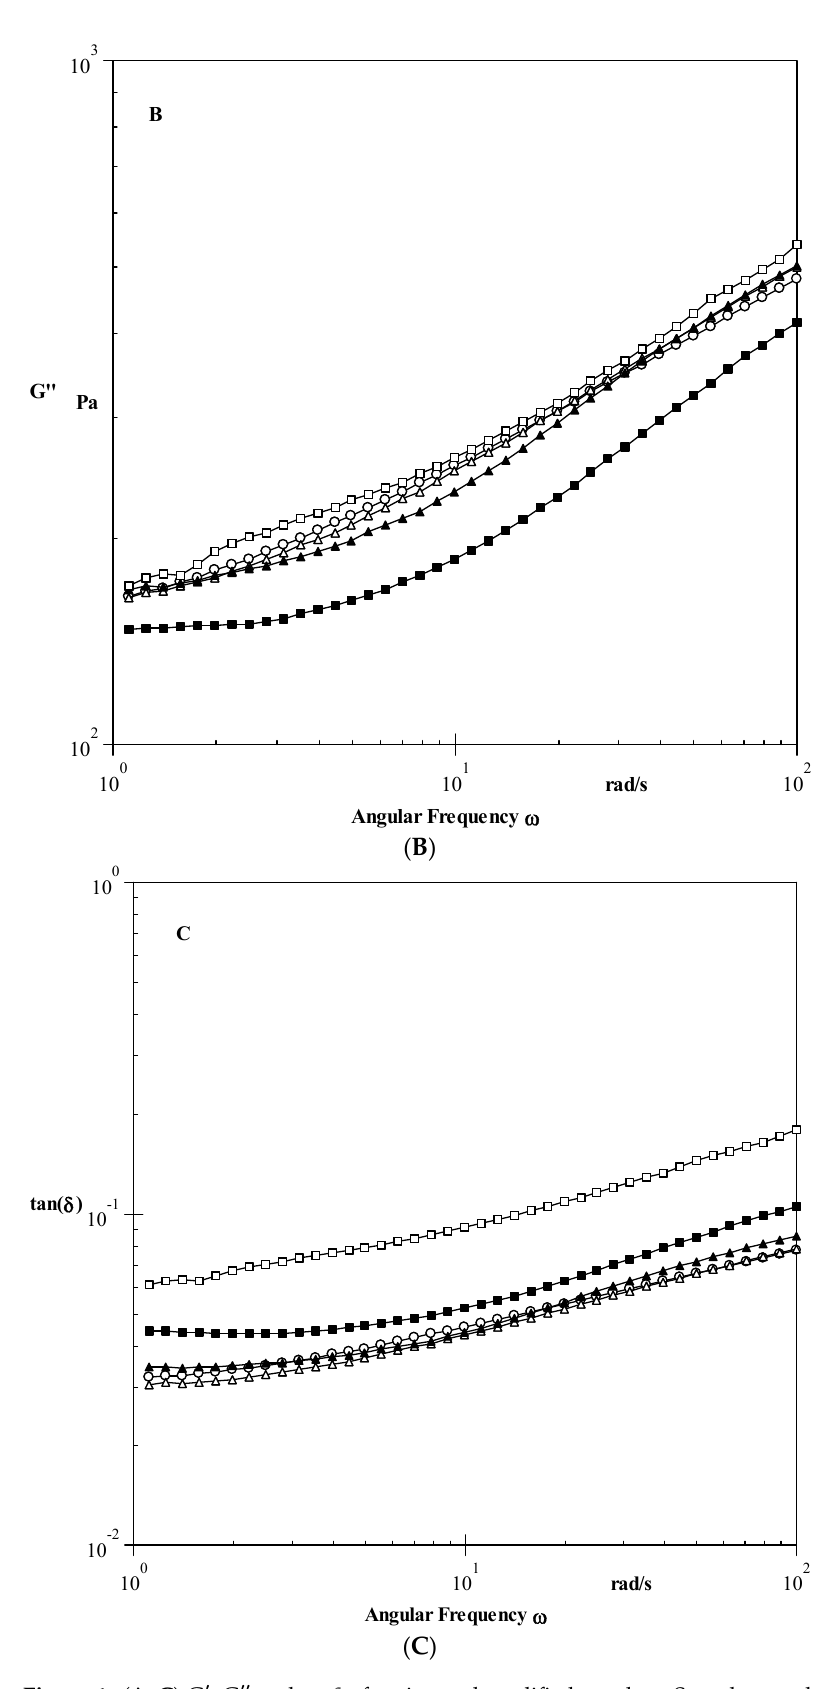
Figure 1. ( A – C ) G ′ , G ″ and tan δ of native and modified starches. Samples are denoted by o-Native; ∆ -(Cross-linking at 0.1%); ▲ -(Cross-linking at 0.3%); ■ -(Cross-linking at 0.5%); □ -(Cross-linking at 0.8%).